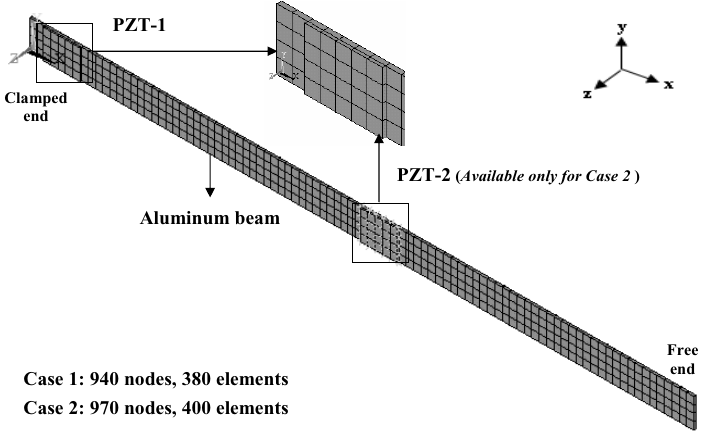
Fig. 2. The FE model of the smart structure for Case 1 and Case 2, aluminum beam of 450 mm × 20 mm × 1.5 mm, and piezoelectric patches of 25 mm × 20 mm × 1 mm. displacements are exported to a text file. “ incon.txt ” command file is created from the nodal displacement file by a computer program automatically. VisualBASIC is used for this in this